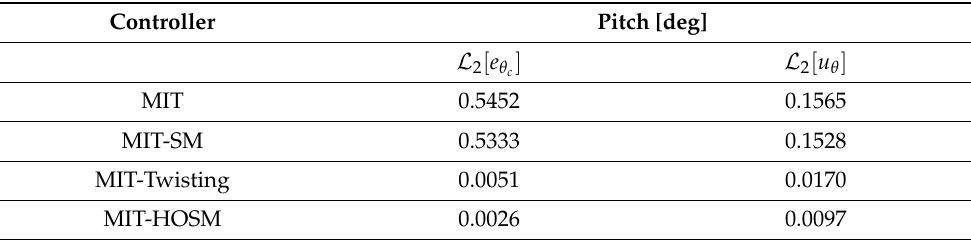
Table 1. Numerical results with L 2 of the adaptive robust controllers in pitch angle.